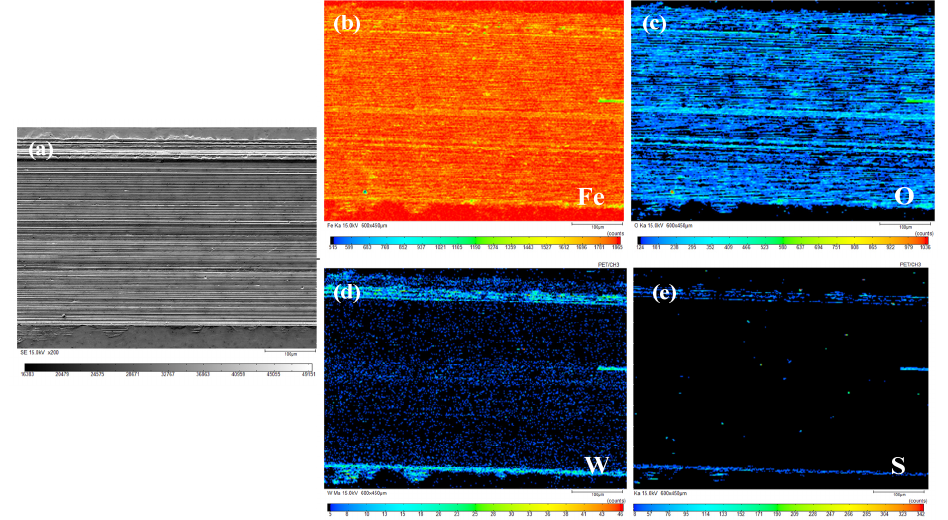
Figure 12. Element distribution diagram of wear scar of sample oil #2 (load: 120 N, sliding speed: 20 mm/s). ( a ) Scanning image; ( b ) Element Fe; ( c ) Element O; ( d ) Element W; ( e ) Element S.